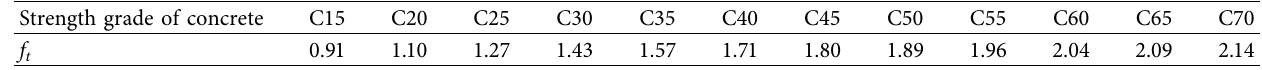
Figure 11: The relationship between f Table 3: Design value of axial tensile strength of concrete (N/mm 2 ).